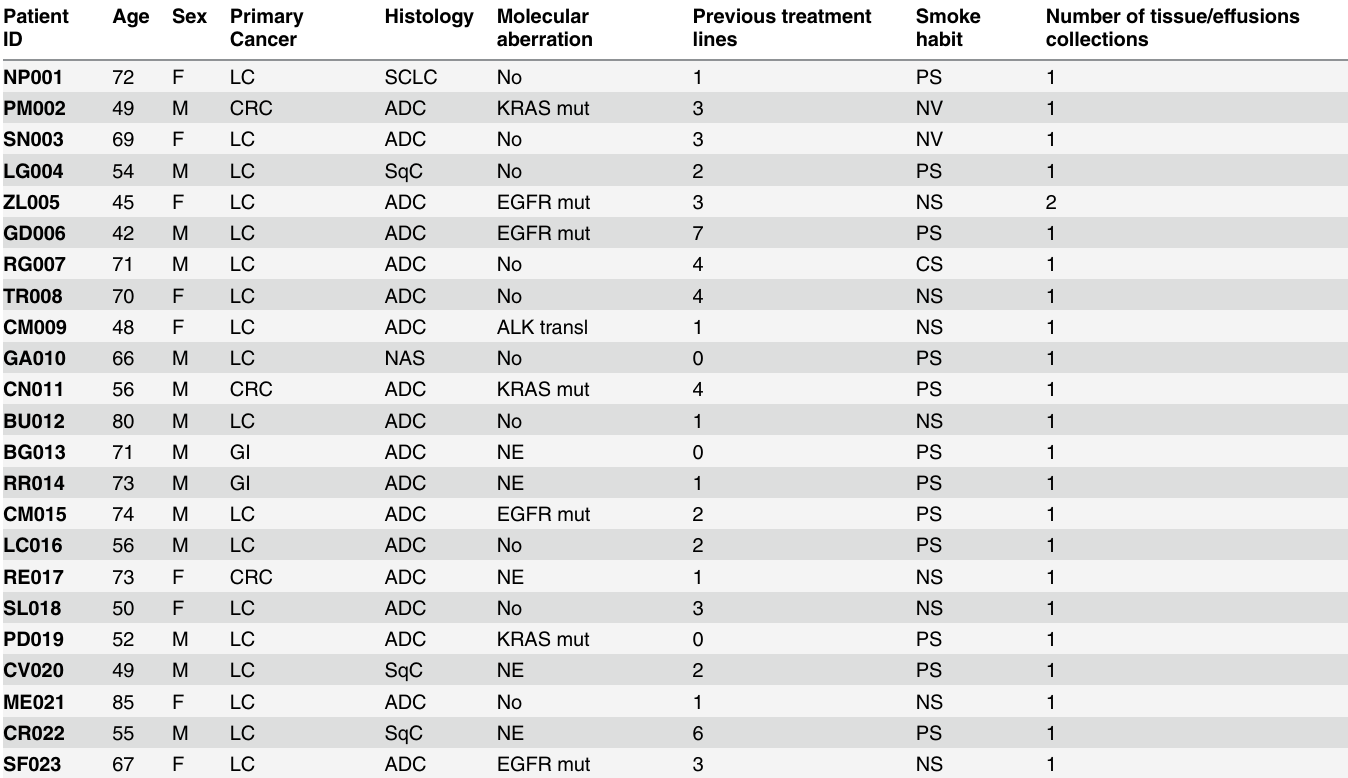
Table 2. Individual patients